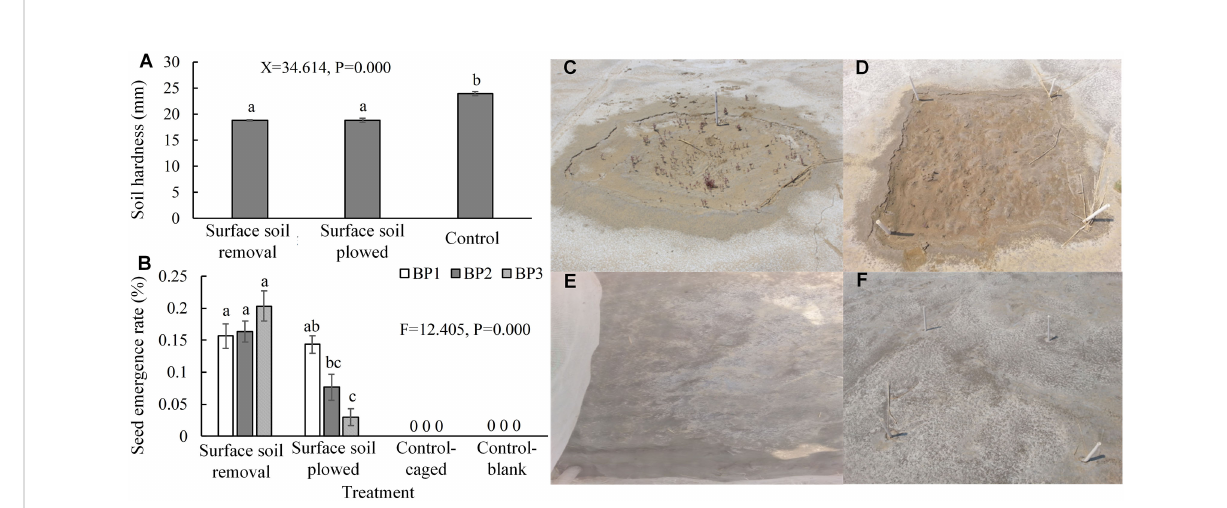
FIGURE 7 Soil hardness and the seed emergence rates after surface soil removal and plowing. (A) Soil hardness after the two treatments. Each group is a combination of the treatments for each of the three types bare patch (N = 54 with 18 controls from three bare patches). (B) Results of seed addition when the two treatments were applied (N = 72 with 32 controls). (C, D) Photographs of emerged S. salsa seedlings after the removal and plowing treatments, respectively. (E, F) Photographs of the caged and blank control treatments showing no emerged seedlings, respectively. BP1, BP2, and BP3 represent complete-enclosed, semi-enclosed, and open bare patches, respectively. Data are means ± SE and signi fi cant differences are shown by different letters above the